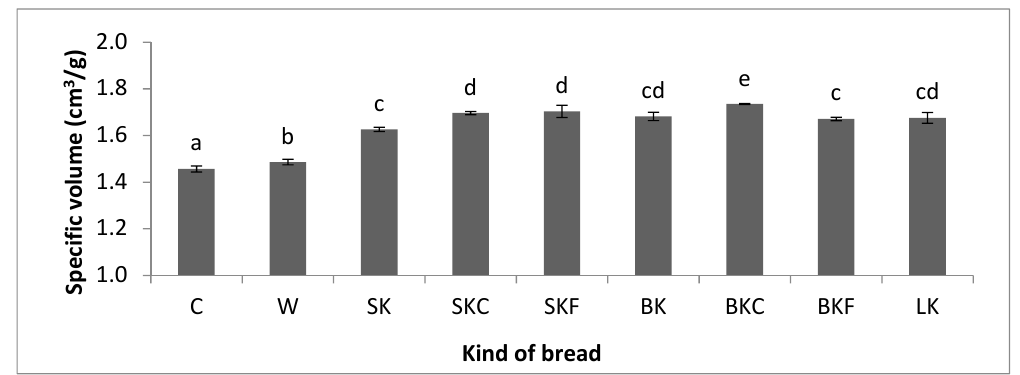
Figure 3. Specific volume of gluten-free bread with ground flaxseeds. C—control gluten-free bread, W—gluten-free bread with whole flaxseeds, SK, SKC, SKF, BK, BKC, BKF, LK—gluten-free bread